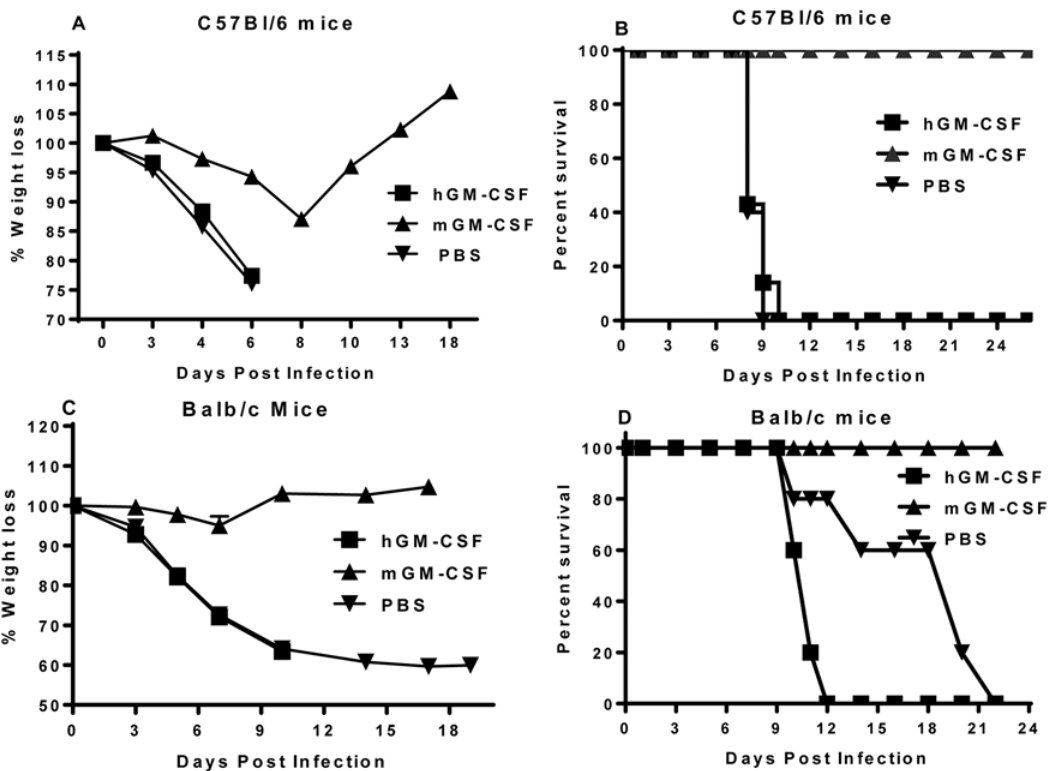
Fig 1. Pulmonary GM-CSF protects mice against influenza infection. C57BL/6 (A and B) and Balb/c (C &D) mice were treated with either murine GM-CSF (mGM-CSF) or human GM-CSF (hGM-CSF) intranasally daily for one week, and a control group was treated with PBS. Mice were then infected with a lethal dose of mouse-adapted influenza A virus PR8. Infected mice were monitored and their weight loss (A and C) and mortality (B and D) were recorded daily. A representative of two to four independent experiments with similar results is shown. (n = 5 – 7 mice/group).